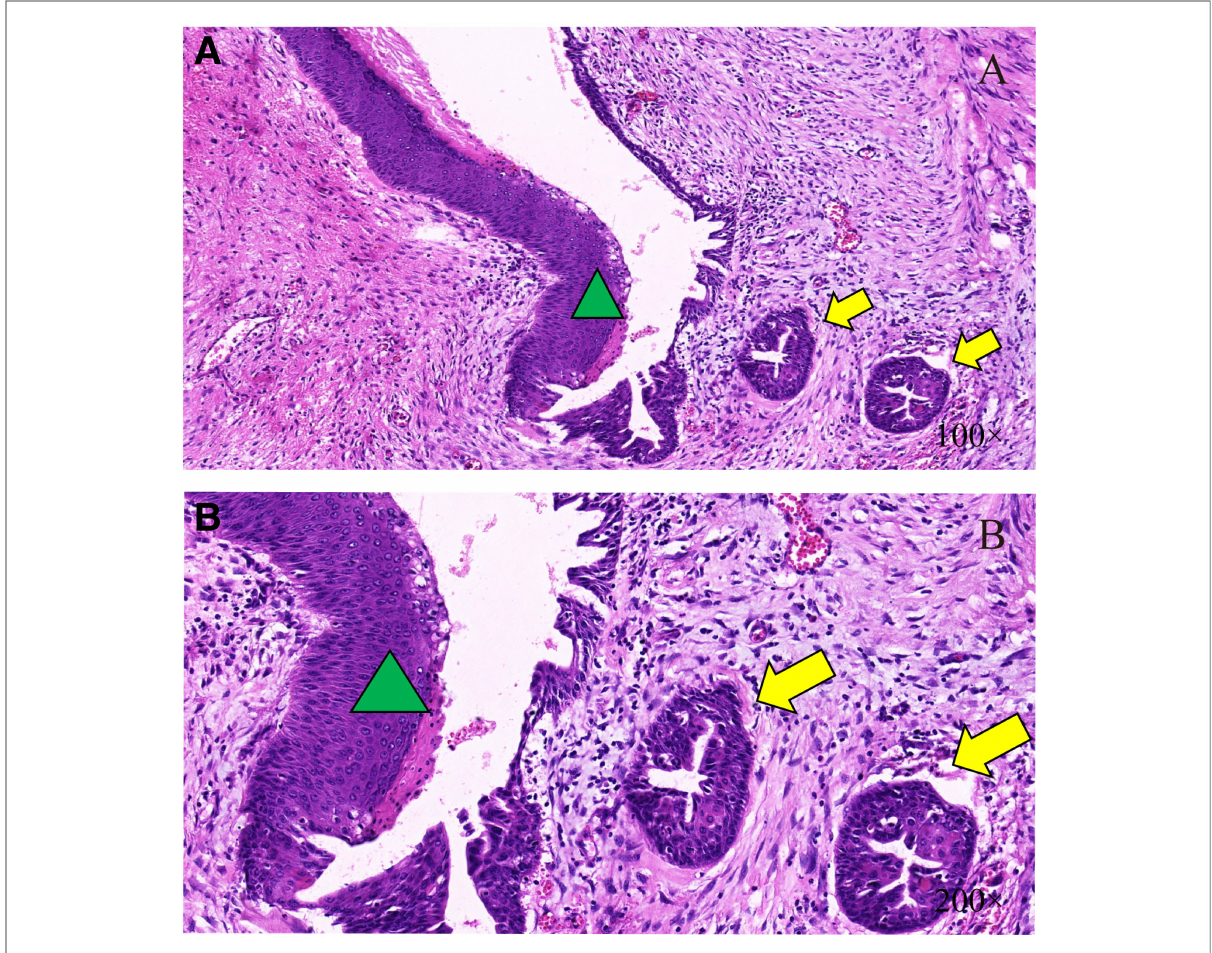
FIGURE 4 Histology studies of the duct epithelium. The male mammary duct epithelium (green triangle) was local squamous metaplasia, forming cysts (yellow arrow); H&E ×100 ( A ) and H&E ×200 ( B